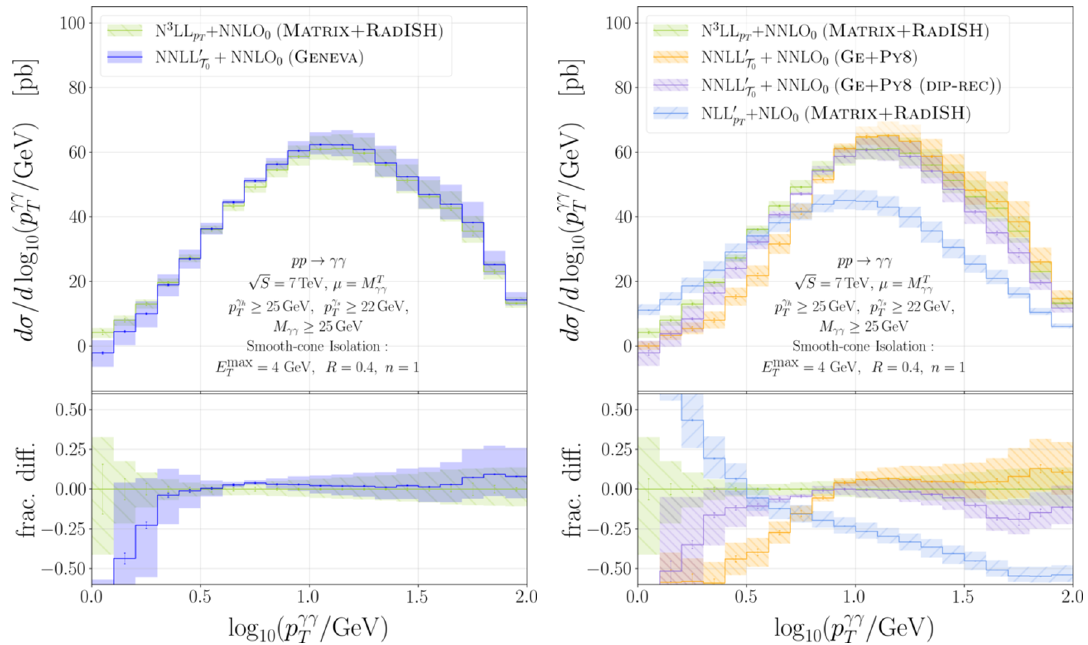
Figure 9 . Comparison with Matrix+RadISH for the p γγ accuracies. Geneva results before showering are shown on the left panel, after showering but before hadronisation on the right